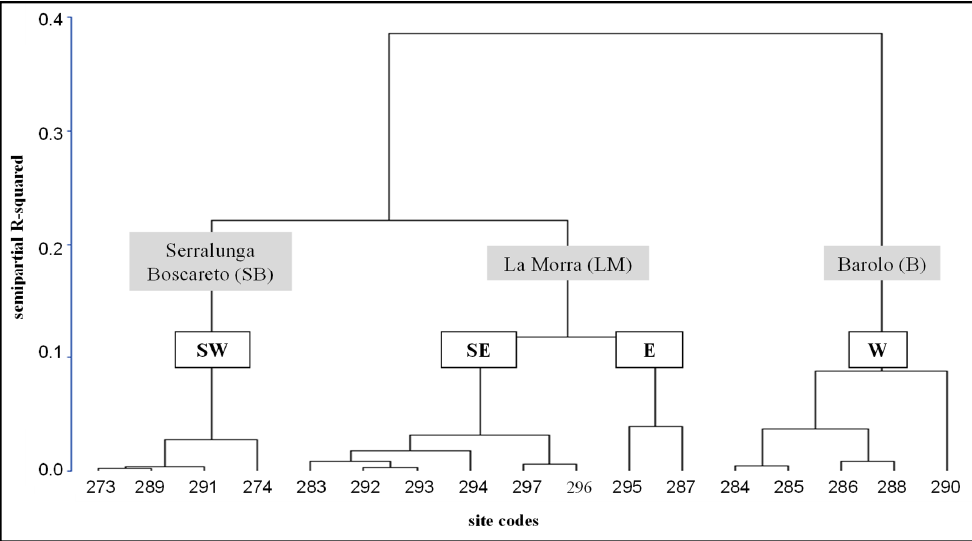
Figure 4. Grouping of the vineyards based on the Cluster Analysis carried out on the geographical variables (i.e., aspect, elevation, slope gradient, and intercepted surface solar radiation), dominant slope aspect of each group and mesoclimatic units to which groups belong are also indicated. Table 1. Vineyard codes, urban district, mesoclimatic unit (MU), group membership obtained by cluster analysis, and main topographic features of the vineyards investigated; average values were calculated for each group.